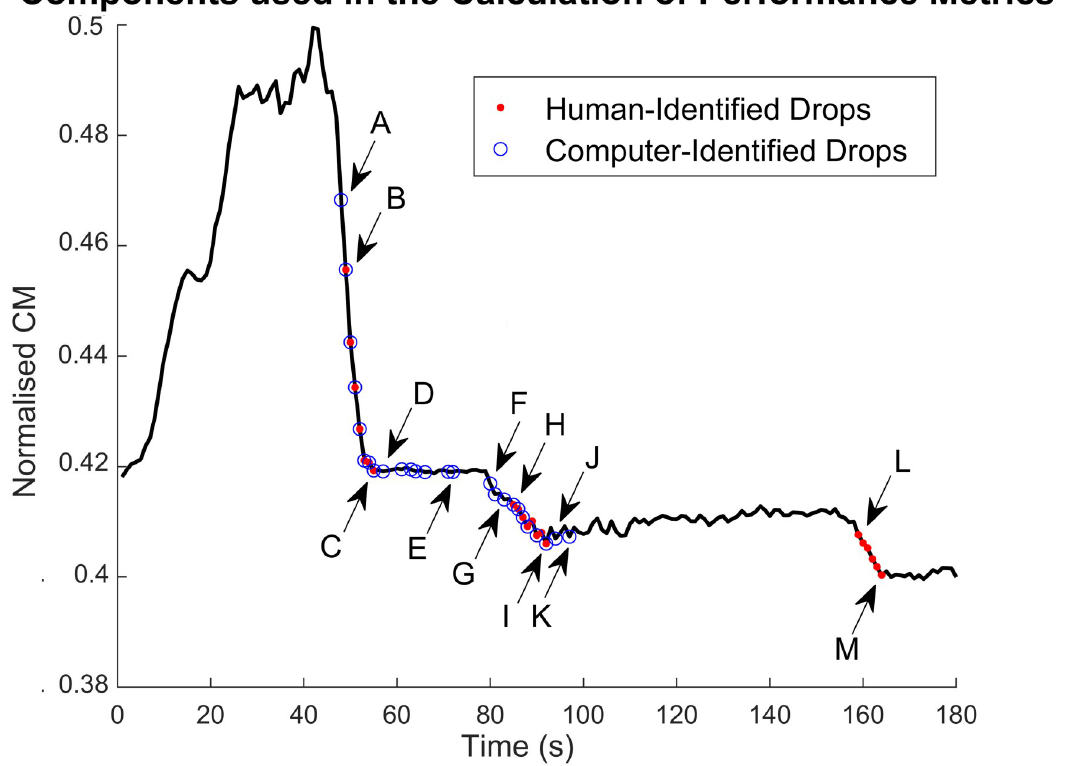
Fig 5. Components used in the calculation of performance metrics. B-C and H-I are True ‘Drops’. L-M are False ‘No Drops’. D-E and J-K are False ‘Drops’. A and F-G are drops identified before the human expert and therefore are considered to be True ‘Drops’. All other instances are True ‘No